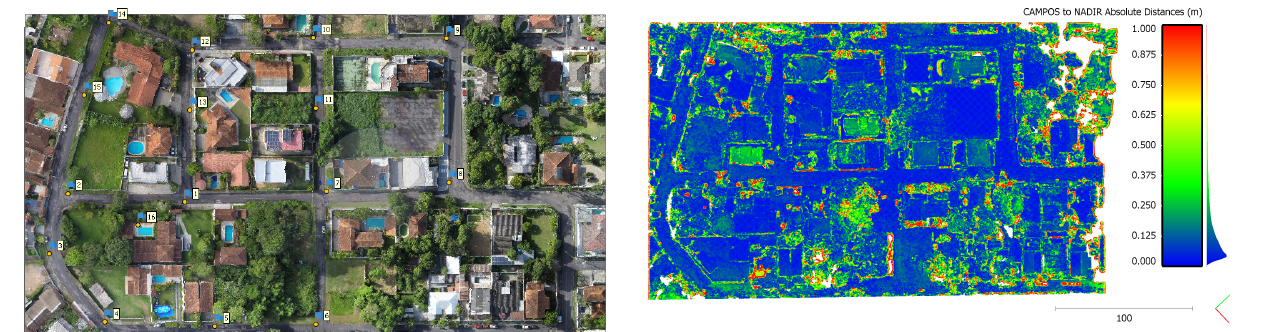
Figure 11. GCPs locations of field experiments.